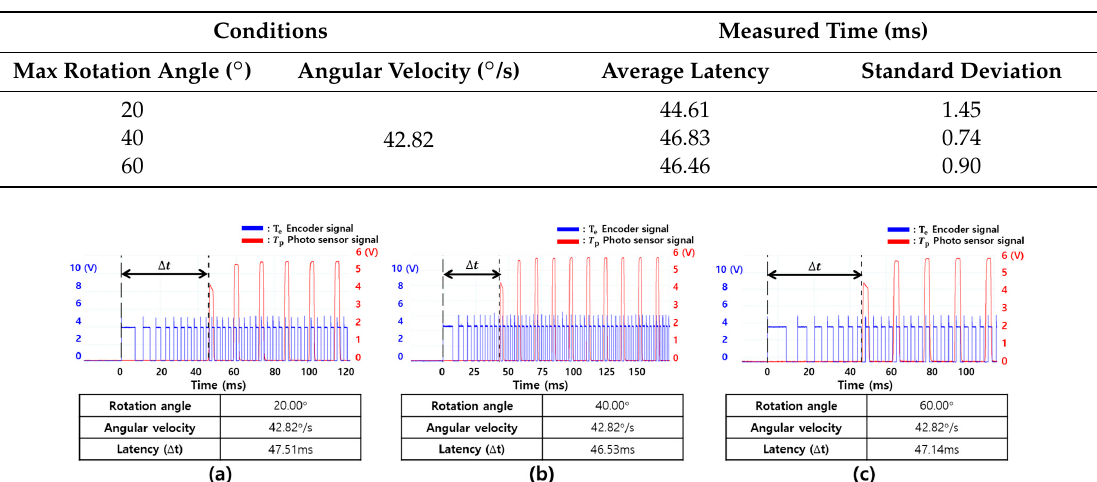
Table 2. Average latencies and standard deviations for different rotation angles (yaw rotation).